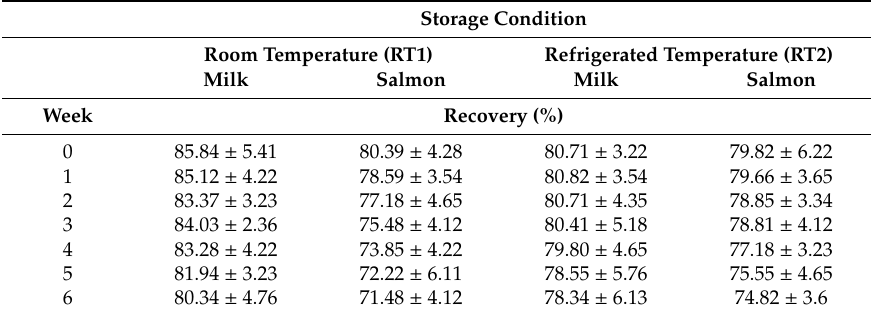
Table 4. Recovery (ng) of FF spiked at 300 ng concentrations in milk and fish extracts showing storage e ff ect and shelf life of nanoMIPs immobilized on